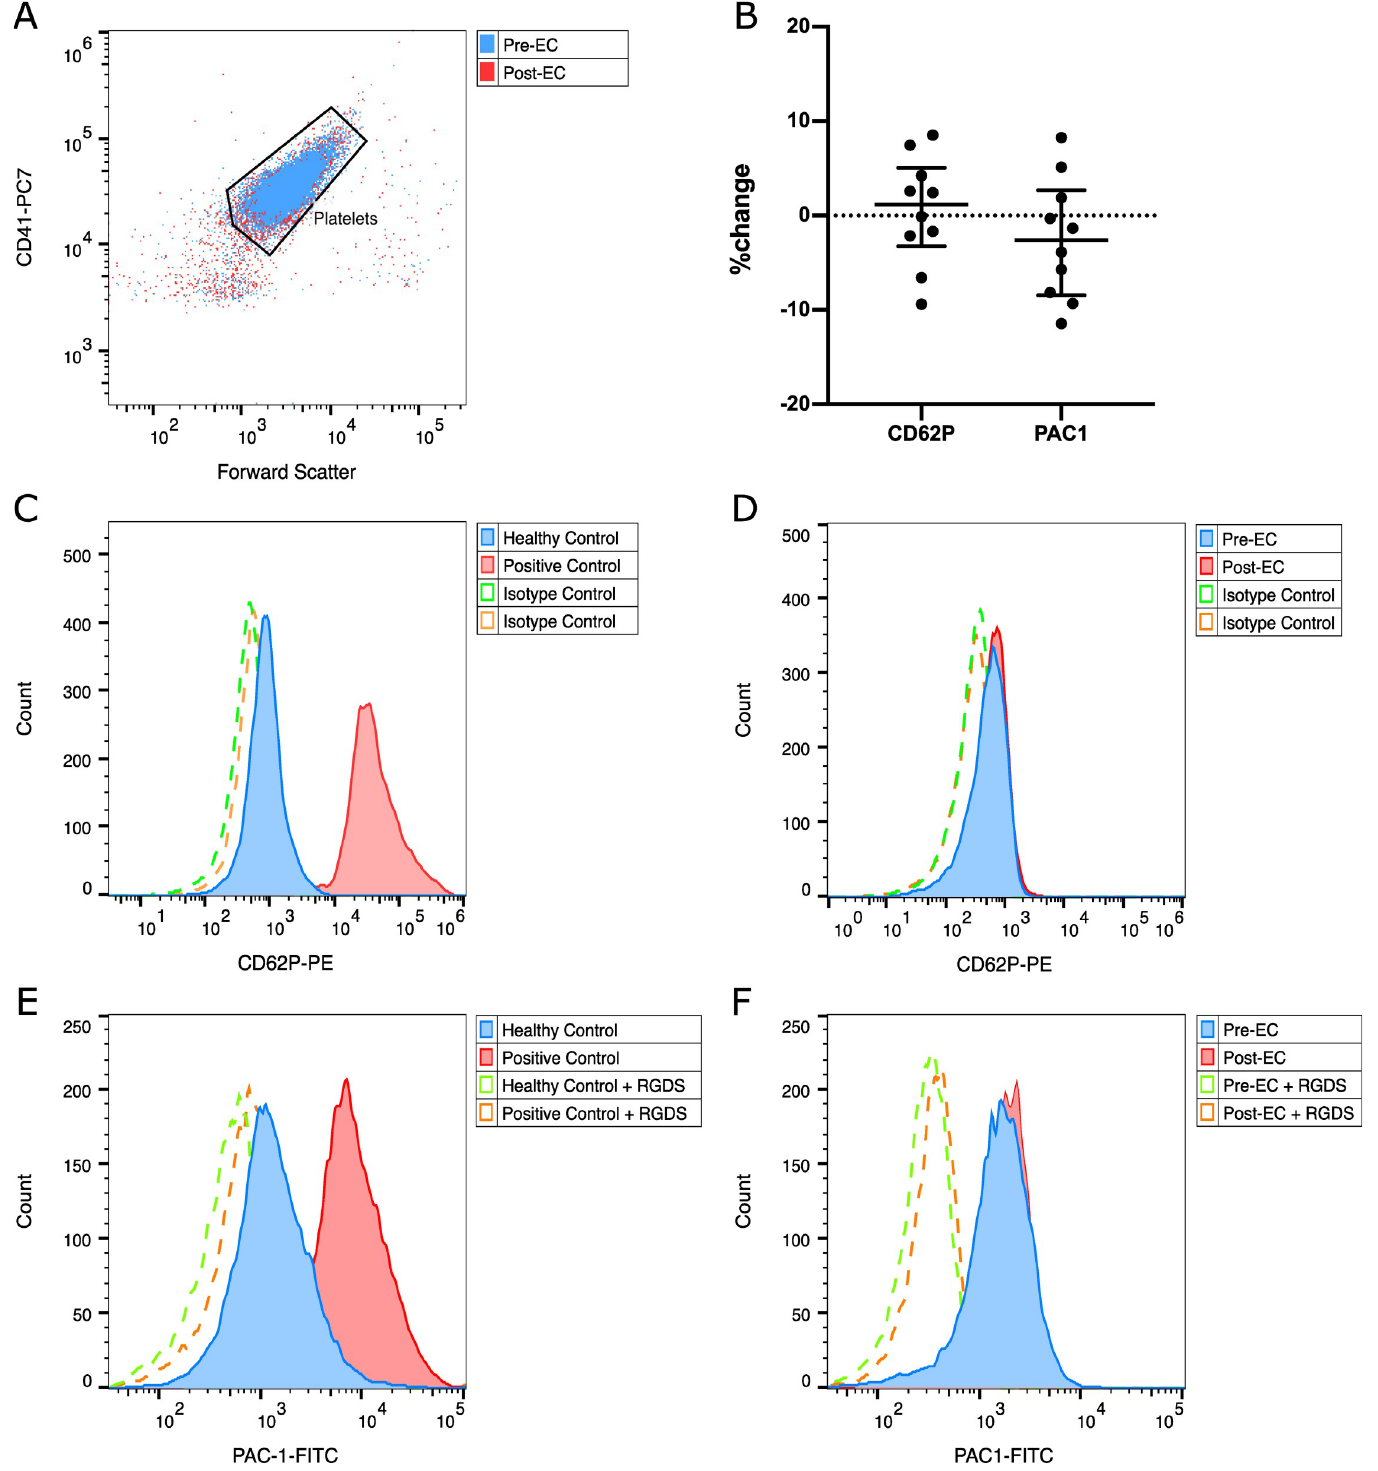
Fig 1. Flow cytometric analysis of expression of CD62P and activated integrin α IIb β 3 before and after EC. (A) Gating strategy based on the pan-platelet-marker CD41-PC7, (B) relative changes of CD62P and activated integrin α IIb β 3 of each patient, (C) CD62P expression of a non-stimulated healthy control (blue) and after in vitro stimulation with collagen (red), (D) representative histogram of CD62P expression of a patient before (blue) and after (red) EC, (E) activated integrin α IIb β 3 expression of a non-stimulated healthy control (blue) and after in vitro stimulation with collagen (red), (F) representative histogram of activated integrin α IIb β 3 expression before (blue) and after (red) EC; (C-F) dashed lines depict isotype controls for CD62P or negative controls for PAC-1.